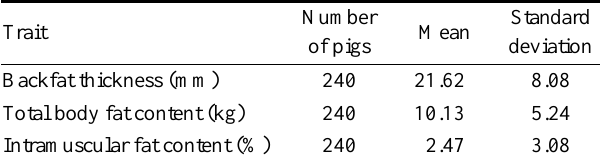
Table 1. Means and phenotypic standard deviations of fat traits